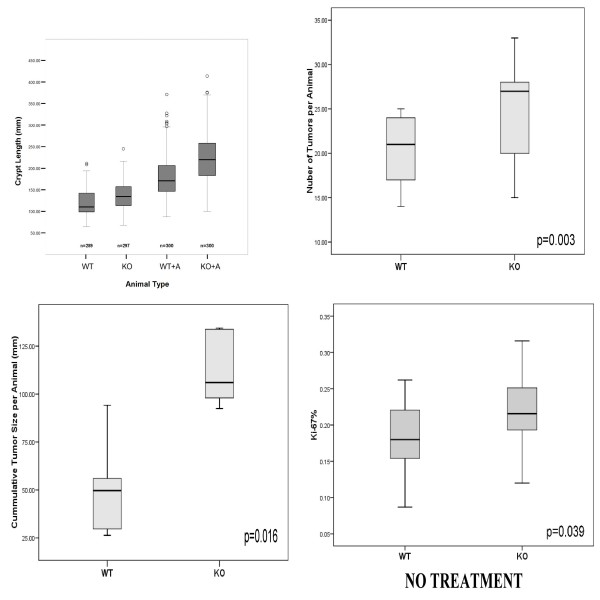
The differences in the measured crypt length were significant before and after treatment by azoxymethane. CyCAP-/- animals spontaneously developed increased crypt length and also developed much more exuberant response to azoxymethane treatment (A), which resulted in more hyperplasia (A) larger number of adenomas (p = 0.003, Linear Regression) (B) and increased cumulative size of adenomas (p = 0.016, Linear Regression) (C). The CyCAP-/- untreated animals also spontaneously developed higher crypt proliferation ratio (p = 0.039, Mann-Whitney Test) (D).